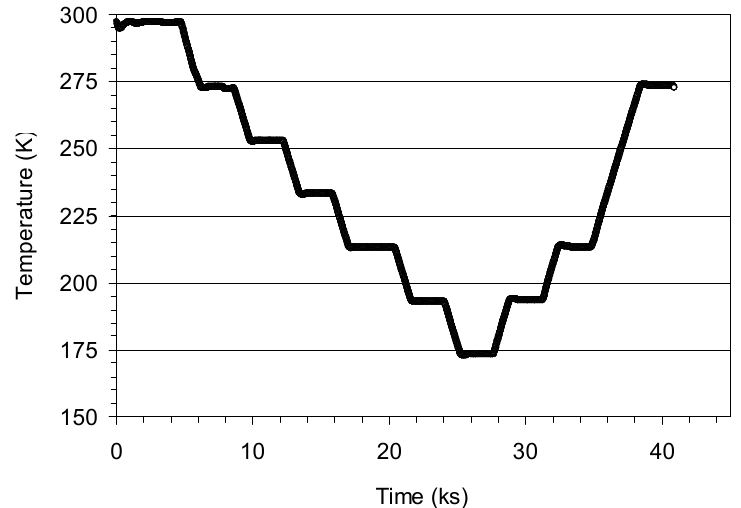
Figure 4. Continuous temperature spectra of the internal friction registered in a cooling–heating scan between 290 and 173 K for a Structure 1 sample with two a/c twin boundaries. Cooling– heating rate 1 K/min, oscillatory strain amplitude 2 × 10 − 7 .